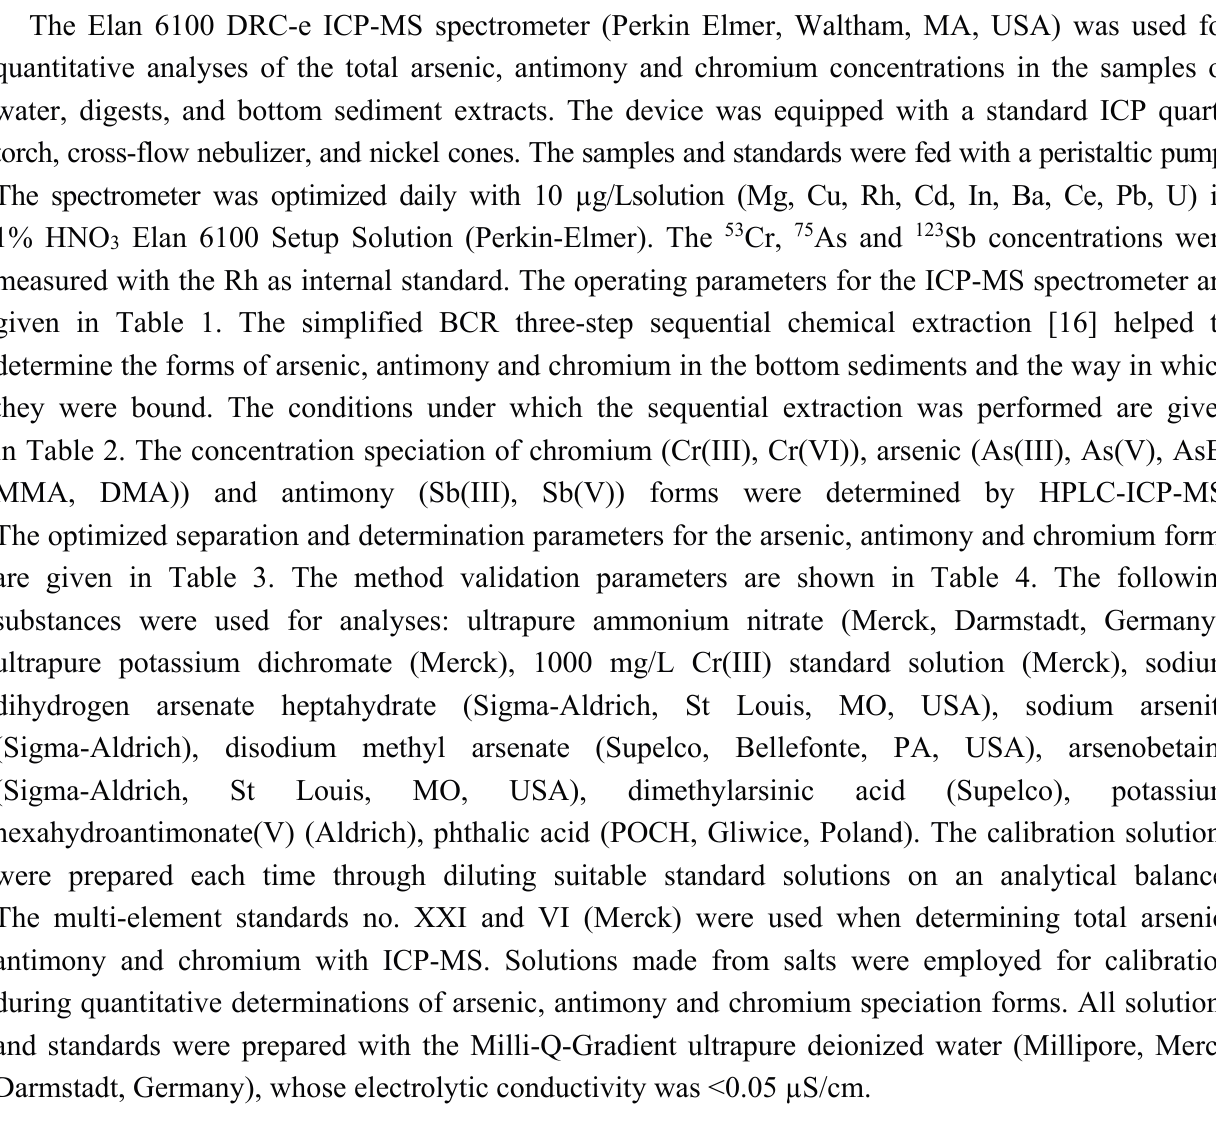
Table 1. ICP-MS spectrometer operating